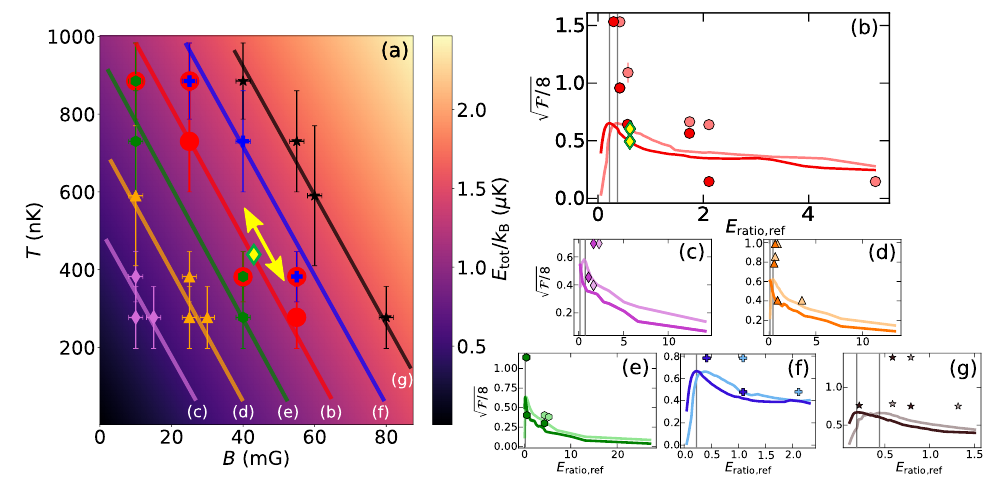
Figure 6: Data and simulation regimes for sensitivity determination in param- eter space. (a) Parameter range for experimentally obtained data and simulations. The sensitivities have been calculated for different total energies, where the yellow double arrow illustrates the change of the reference state along the lines (for simu- lation) and the grouped data points. Due to experimental drifts over long times, the data shows deviations and uncertainties mainly in temperature. We therefore group data points into pre-defined total energies (indicated by symbols) with an average deviation of less than 7% to the corresponding simulated total energy. The lines in- dicate the parameters used for corresponding simulations. The magnetic-field error ∆ B = 2mG is assumed to be constant. For more details see [ 1 ] . Temperature er- rors reflect shot to shot fluctuation. Colorbar gives the total energy. Comparison of measured sensitivity from nonequilibrium data (data points) and steady-state simu- lations (lines) for the parameter indicated by symbols and colors in (a). Simulation is / k = 1.6 (cid:181) K (red lines (b)), 0.7 (cid:181) K (pink lines (c)), 1.1 (cid:181) K (orange calculated for E tot B lines (d)), 1.3 (cid:181) K (green lines (e)), 1.91 (cid:181) K (blue lines (f)) and 2.2 (cid:181) K (black lines (g)). Faded colored (intense colored) lines and data points give the sensitivity of the linear part left (right) of the Bures distance. Diamonds in (a) and (b) mark the ref- erence state (at T = 435nK and B = 43mG for a total energy of 1.6 (cid:181) K) considered in Fig. 4(d), vertical lines mark the maxima of the two simulated